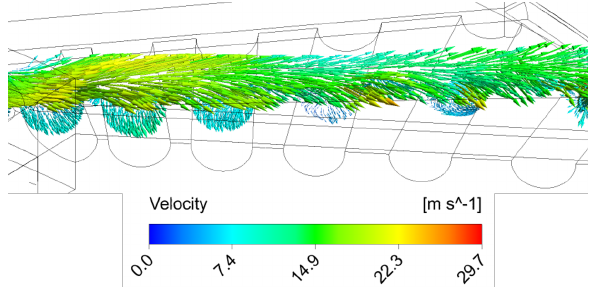
Figure 8: The distribution of the velocity vectors coloured by the velocity in the disc channels (cross-section through the active disc channel axis) for k- ϵ RNG turbulence model